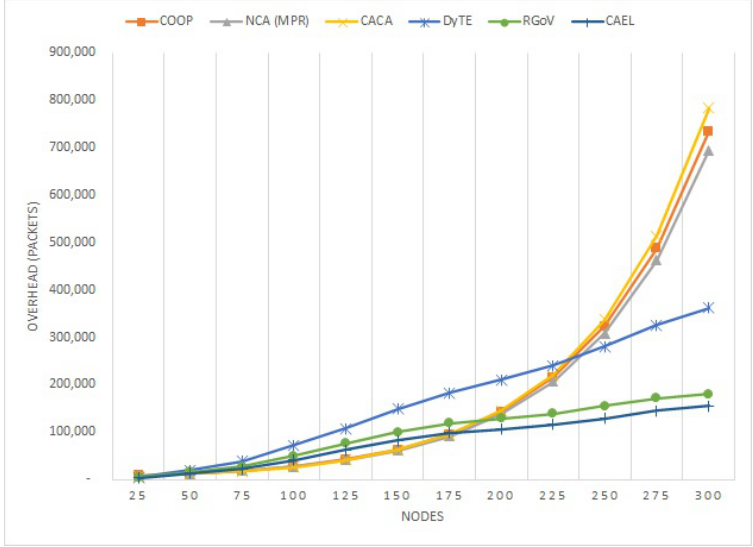
Figure 9. Routing overhead against various number of nodes.